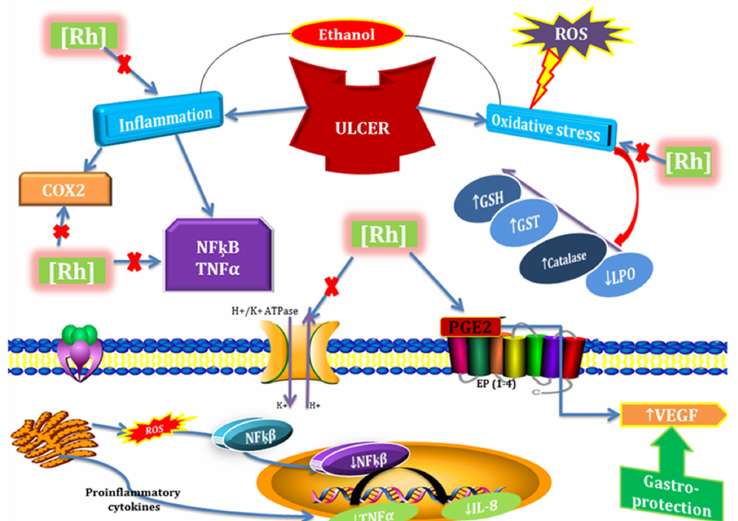
Figure 20. Graphical representation to elaborate the possible mechanism underlying antioxidant, anti-inflammatory, and anti-ulcer potential of Rumex hastatus (RH) against ethanol-induced gastric ulcer. ROS (reactive oxygen species), COX2 (cyclooxygenase 2), NF ƙ B (nuclear factor kappa B), TNF- α (tissue necrosis factor α ), IL-8 (interleukin 8), PGE2 (prostaglandins E2), GSH (glutathione), GST (glutathione-S-transferase), LPO (lipid peroxidation), VEGF (vascular endothelial growth factor).